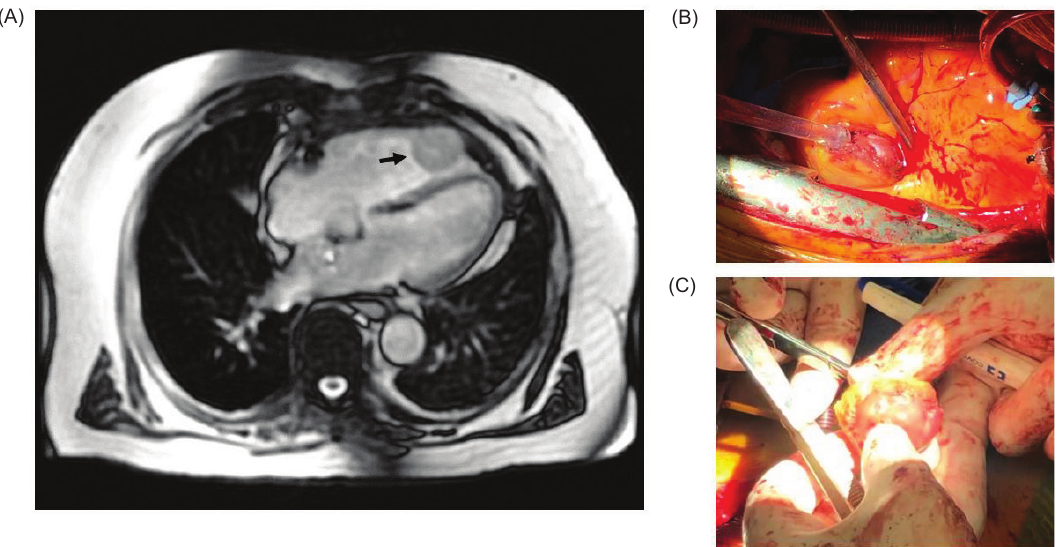
Figure 1: A 77-year-old male with delayed isolated cardiac metastasis from renal cell carcinoma; (A) Computed tomogra- phy demonstrating an enhancing, circumscribed T2 hyperintense T1 isointense right ventricular mass at the ventricular apex measuring 3.5 × 3.3 cm (arrow); (B) Intraoperative image showing the cardiac metastasis identified in the right ventricular wall; (C) Intraoperative image showing the final resected specimen sent for targeted sequencing. A VHL mutation was identified c.494T > G (p.V165G) in exon 3 in 41% of 241